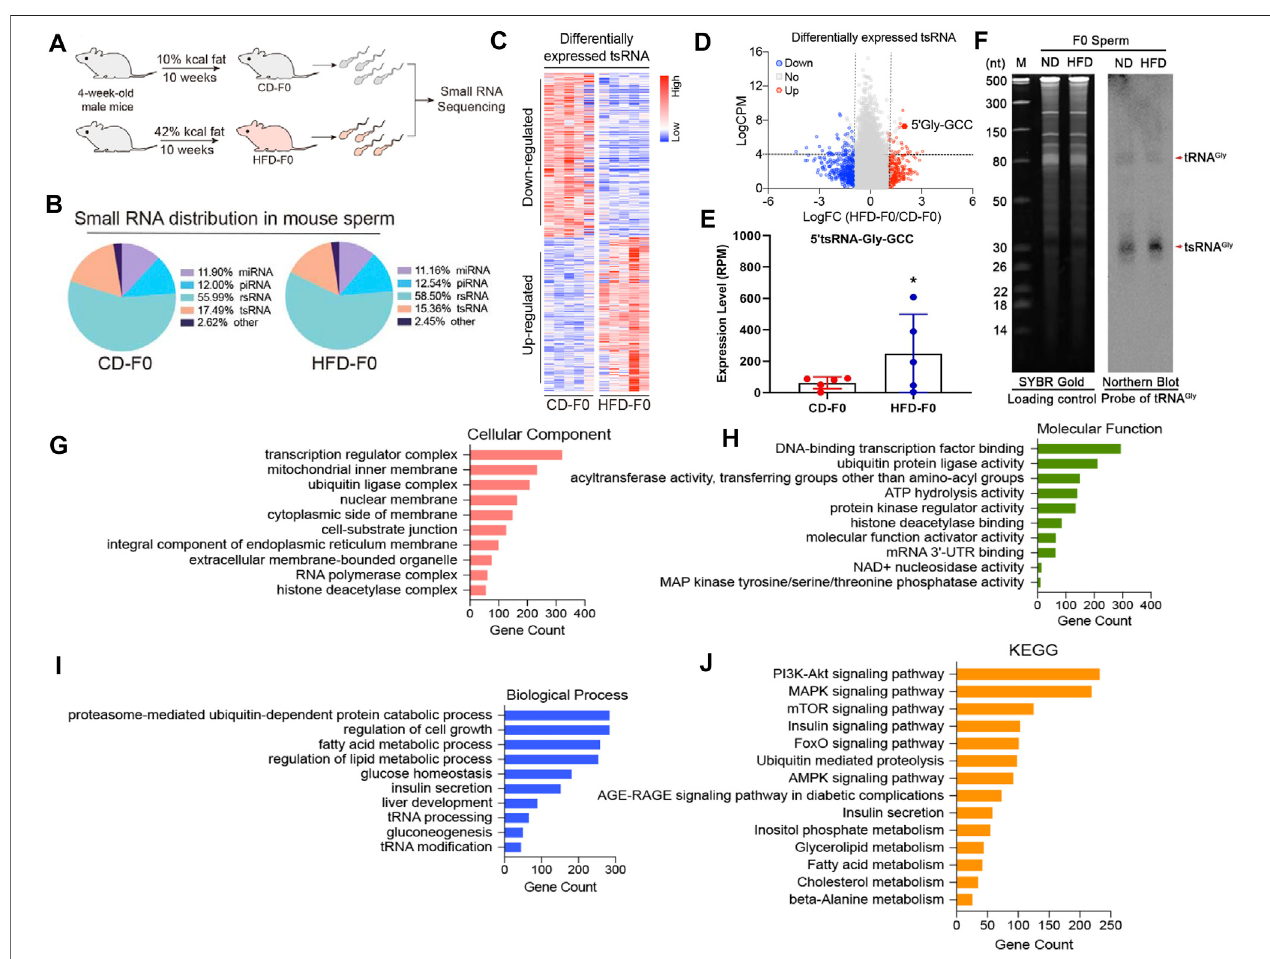
FIGURE 2 | Paternal high-fat diet leads to differential expression of tsRNAs in HFD-F0 spermatozoa and its target genes are associated with metabolic pathways. (A) Two groups of 4-week-old male mice were randomly assigned to receive a control diet (CD; 10% kcal fat) or a high-fat diet (HFD; 42% kcal fat) after 10 weeks of feeding,and sperm wereisolatedfor small RNAsequencing. (B) Types ofsmall non-coding RNAs identi fi edin spermatozoafrom CD-F0and HFD-F0 subjects. (C) Heat mapofdifferentialexpressiontsRNAsacrossall10samples. (D) VolcanoplotshowingthedifferentialexpressiontsRNAbetweenCD-F0andHFD-F0subjects.Red points denote the upregulated tsRNAs and blue points indicate the downregulated ones in HFD-F0 compared to CD-F0 across all 10 samples. (E) Expression levels of 5 ′ tsRNA-Gly-GCC(30 nt)inspermatozoabetweenCD-F0andHFD-F0(n=5). (F) Northernblotanalysesof5 ′ tsRNA-Gly(shownbyarrowheads)inCD-F0andHFD-F0, Sperm total RNAs extracted run on a PAGE gel shown as a loading control. (G – I) Gene Ontology (GO) classi fi cation for predicted target genes of 5 ′ tsRNA-Gly-GCC in three categories (cellular component and molecular function and biological process). (J) Kyoto Encyclopedia of Genes and Genomes (KEGG) functional enrichment analysis for the predicted target genes of 5 ′ tsRNA-Gly-GCC. * p <